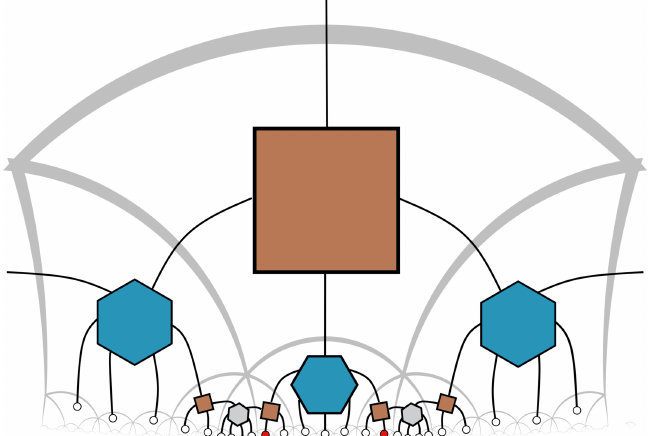
Figure 49. We can also consider correlation function where inserted operators are seprated by a shorter distance (marked red). In this case, we can check that the operators meet at the top tensor after only a single layer. The figures are zoomed into the bottom of the previous figure for